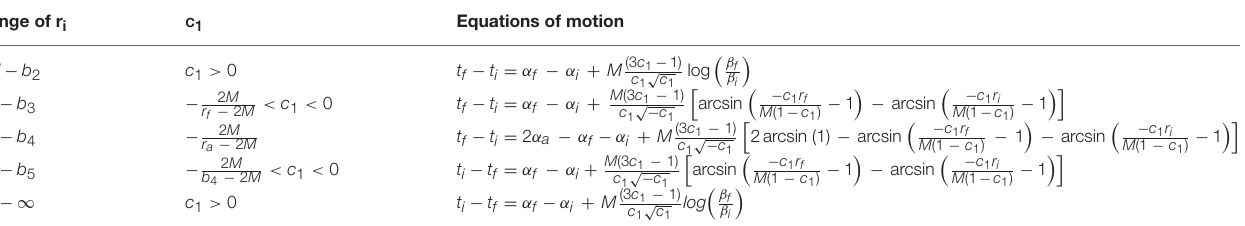
TABLE 1 | Closed-form solution to Equation (12) in Schwarzschild coordinates. Range of r i c 1 Equations of motion